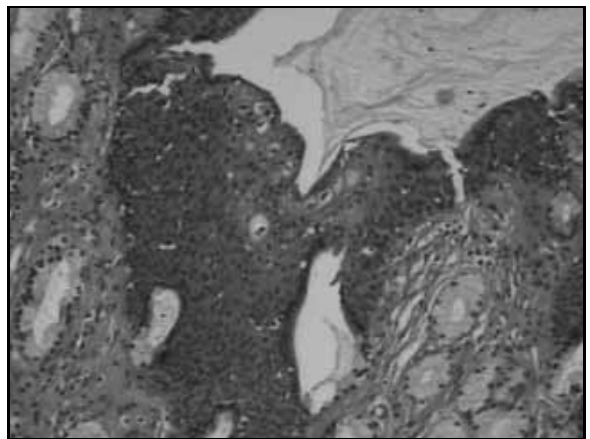
Figure 3 – Ductal epithelium lined by squamous metaplasia (HE, magnification 100×) HE: hematoxylin and eosin.